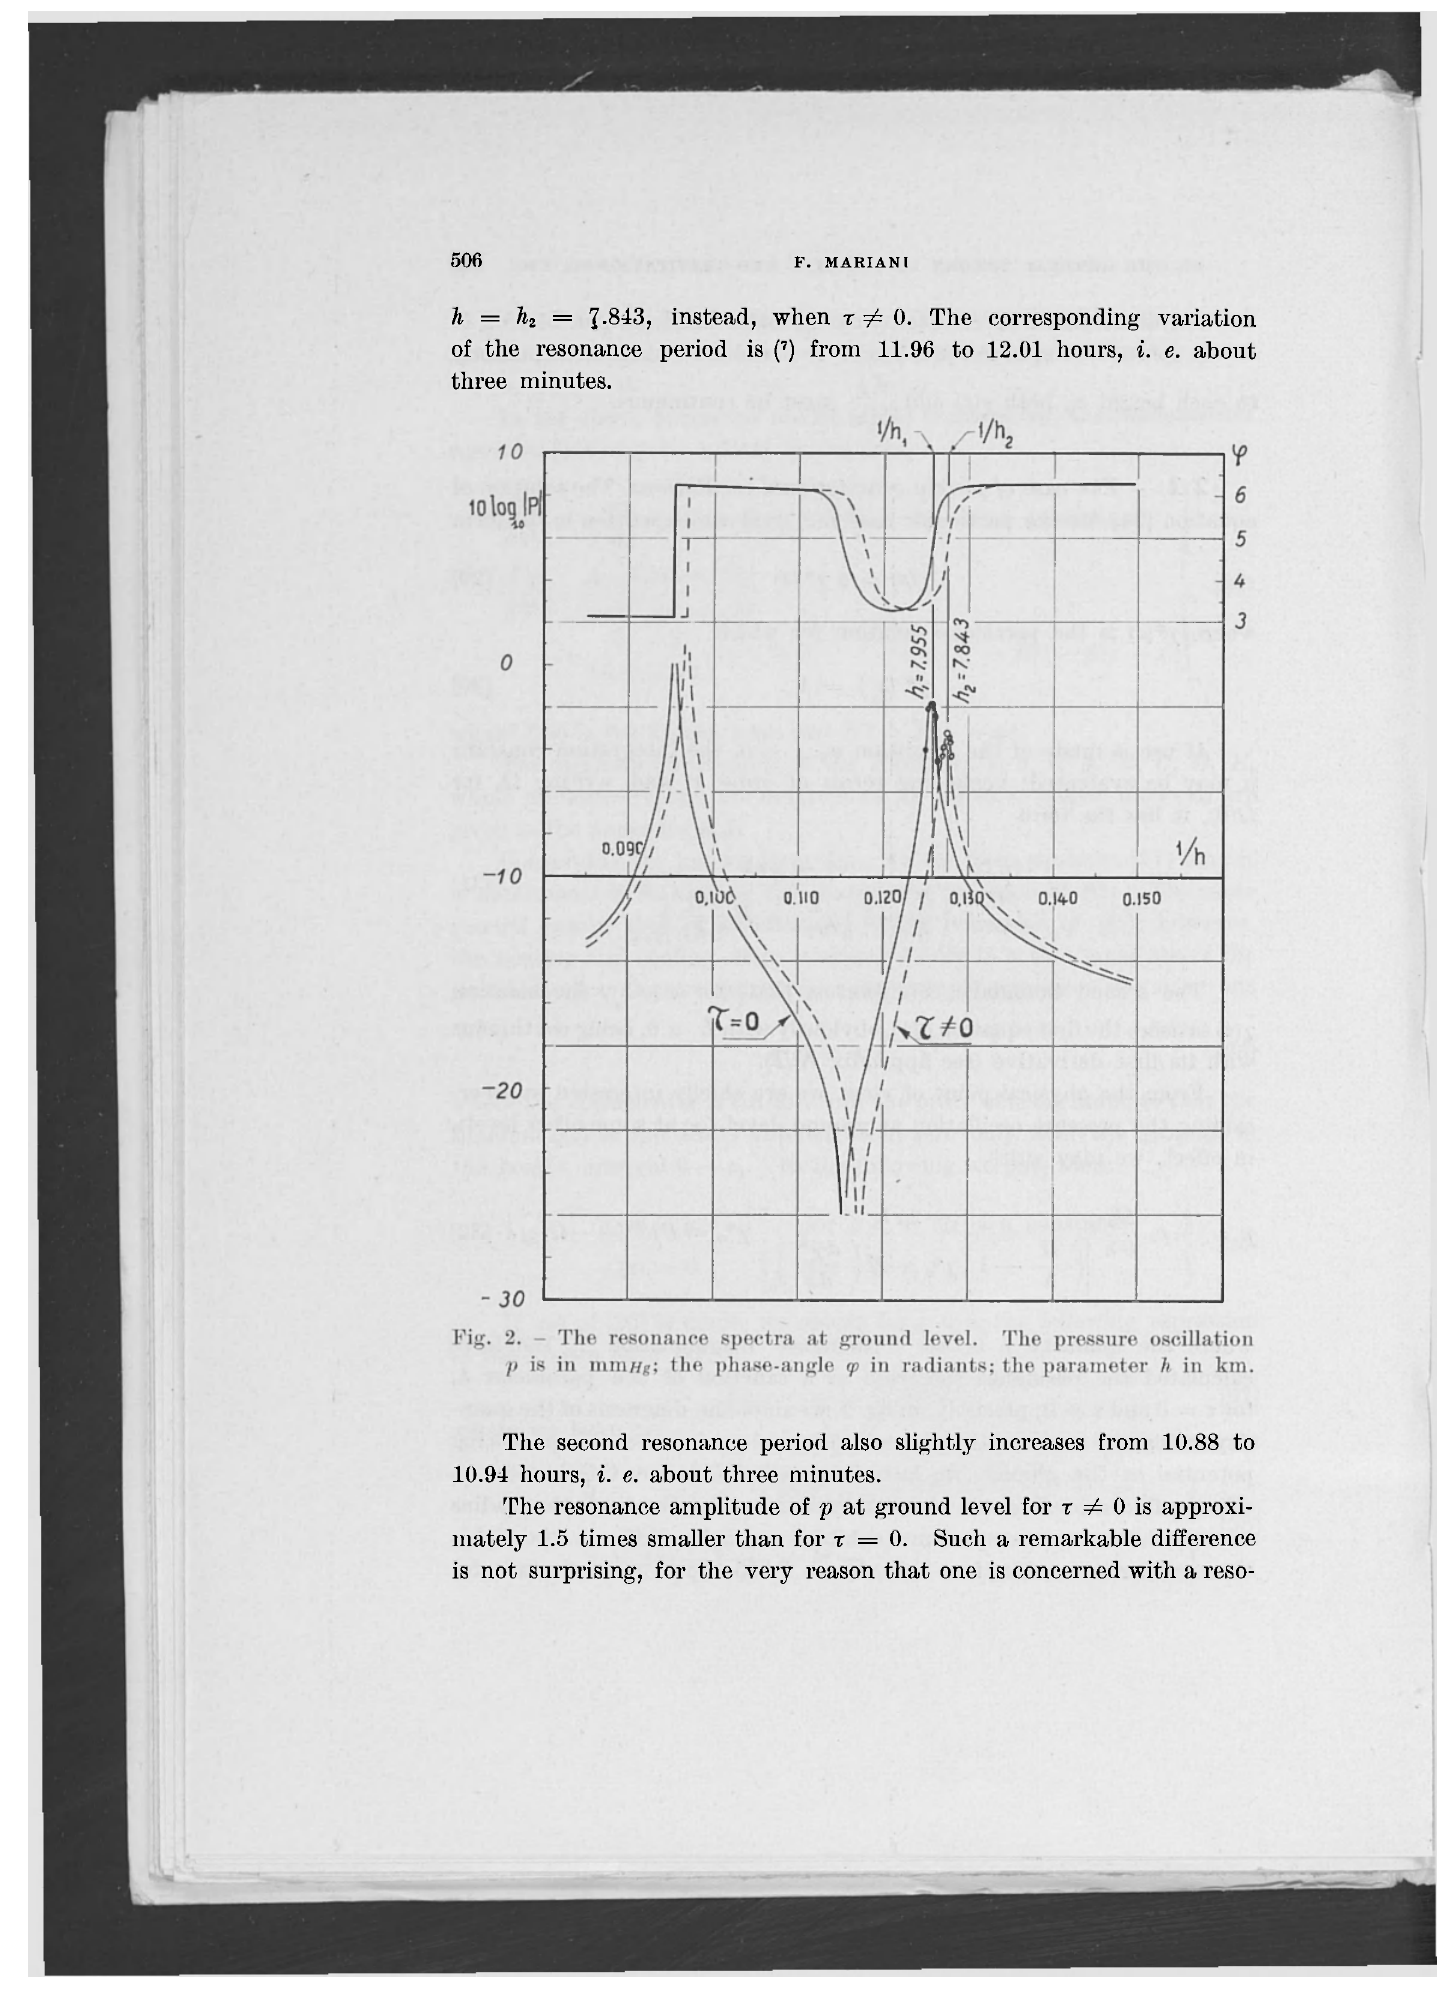
h = h = 7.843, instead, when r # 0. The corresponding variation z of the resonanee period is (') from 11.96 to 12.01 hours, i. e. about three